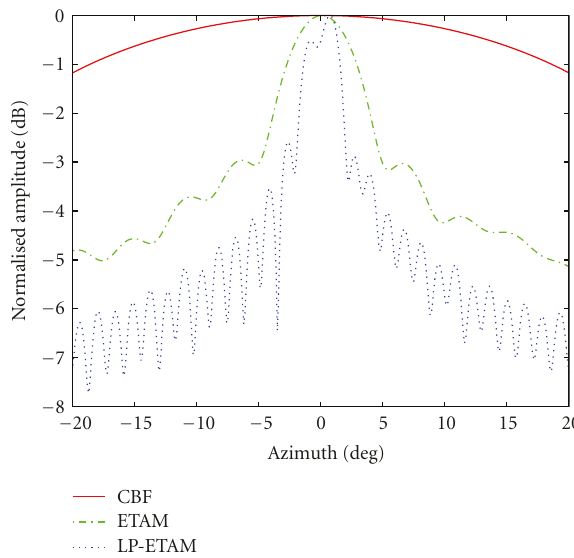
Figure 5: The comparison of spatial spectrums of the three methods for two closely-spaced sources.